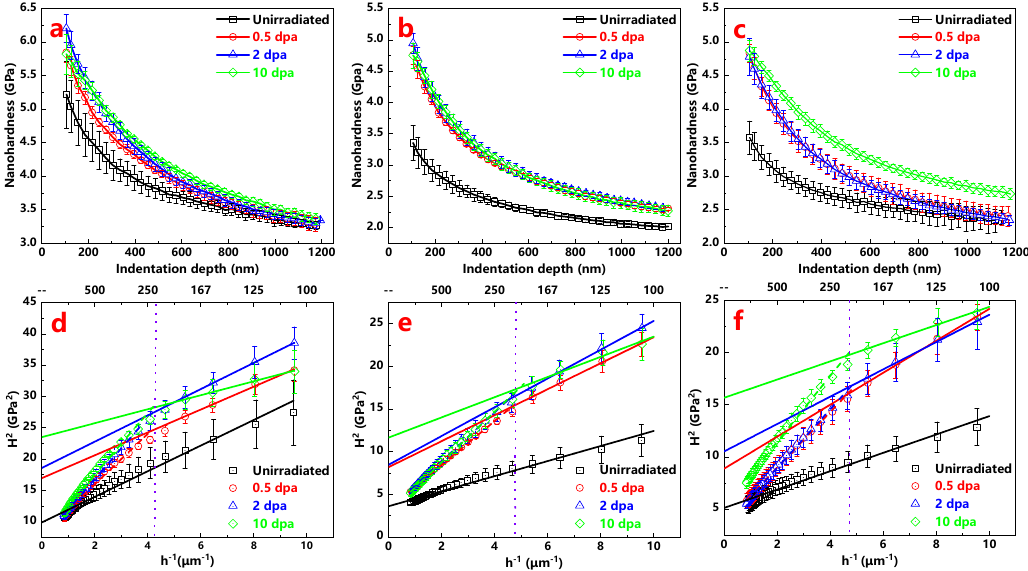
Figure 2. Profiles of average nanohardness in the function of the indentation depth of the ( a ) Hastelloy N alloy; ( b ) Alloy 800H; ( c ) 316H stainless steel before and after irradiation and ( d – f ) the corresponding curves of H 2 versus 1/h.